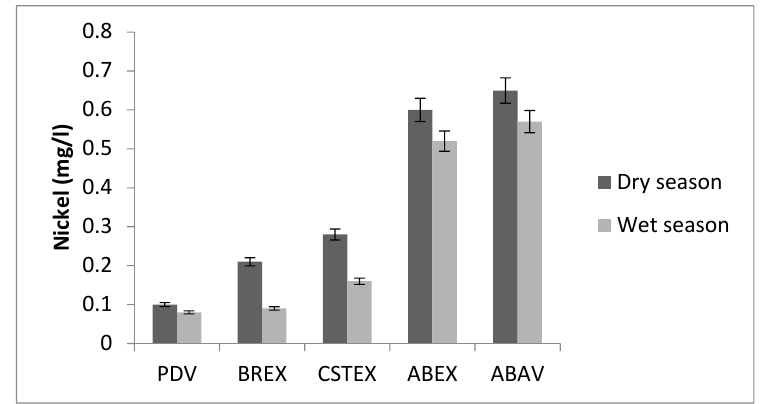
Figure 5. Nickel concentration.